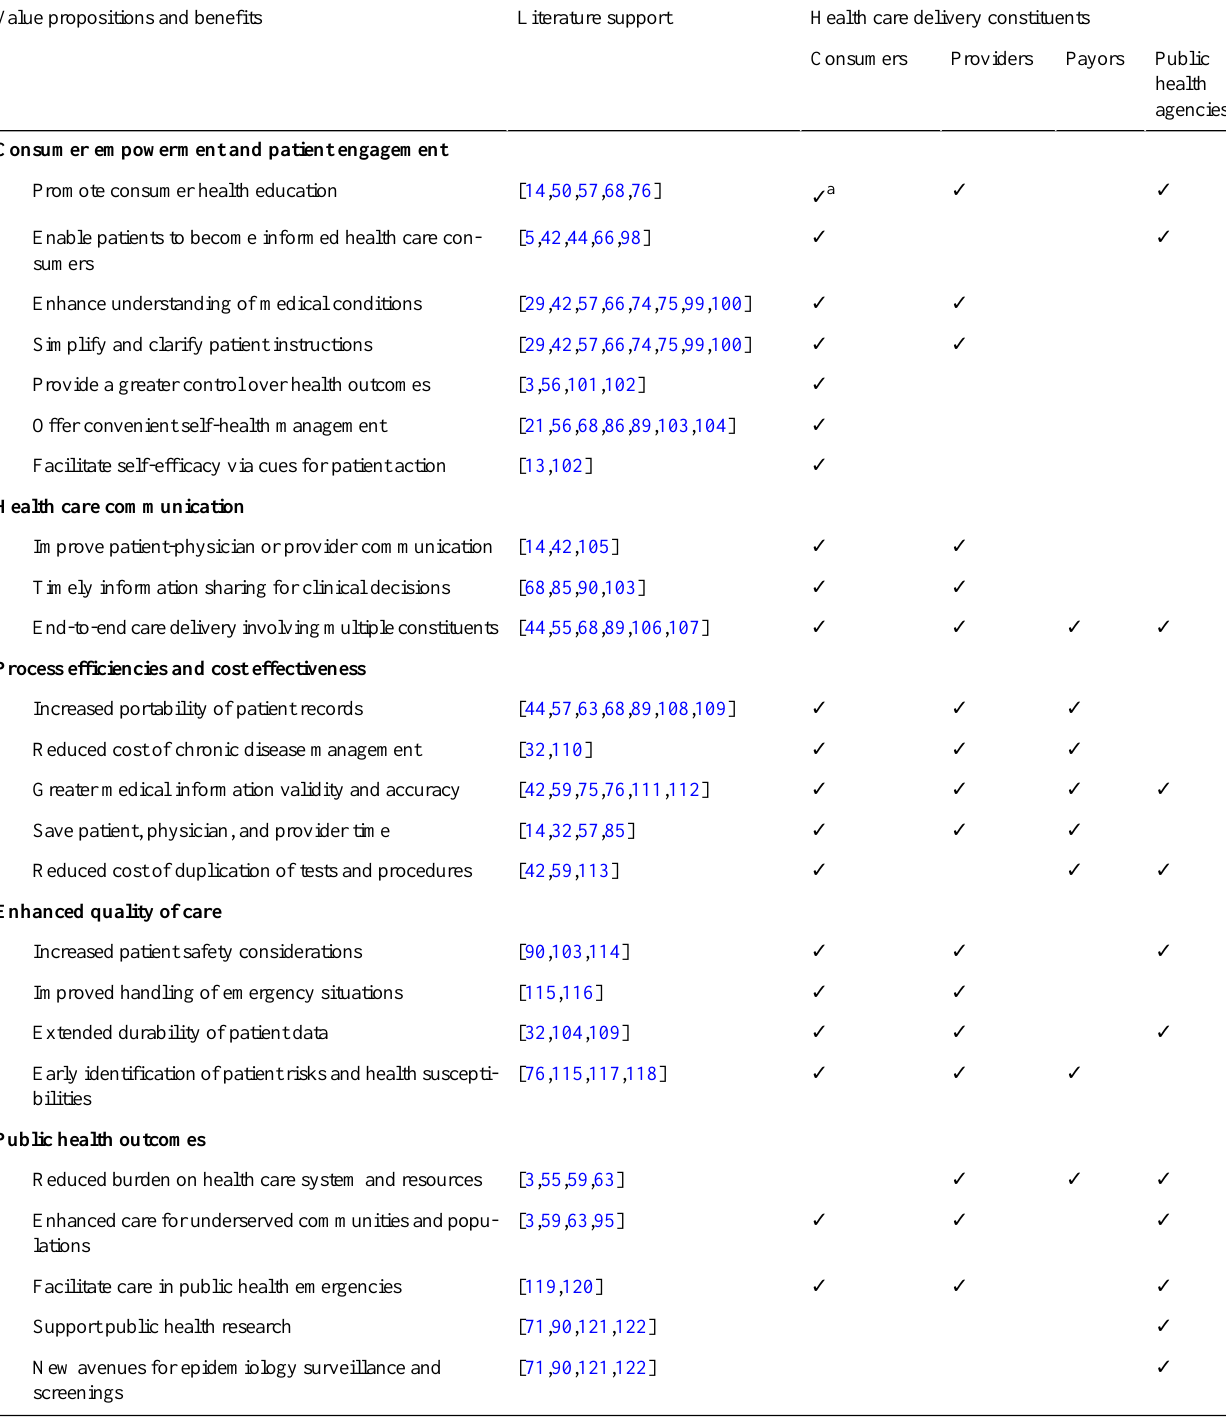
Table 2. Value propositions and benefits of personal health record systems to health care delivery